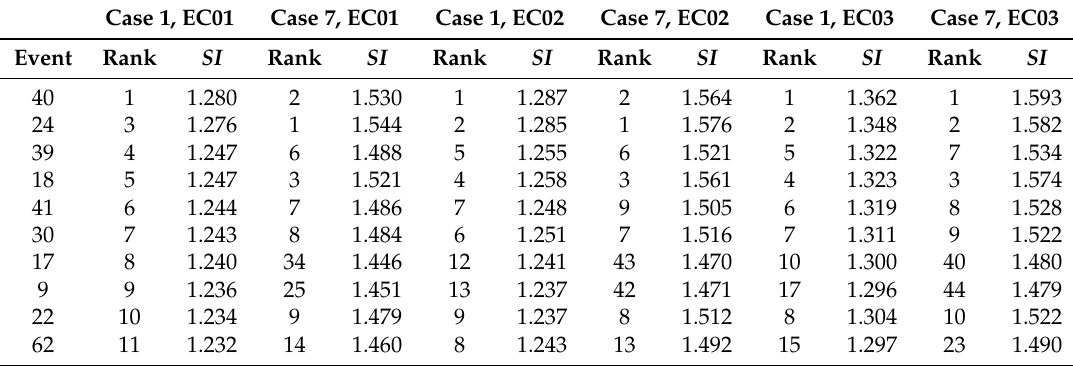
Table 2. List of Top 10 Most Severe Contingency Events and Their Ranking for Selected